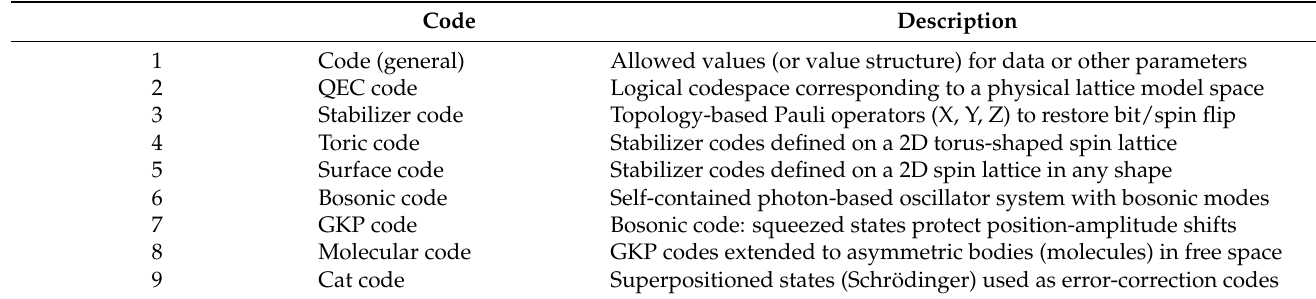
Table 2. Codes for Quantum Matter Characterization, Creation, and Manipulation. Code